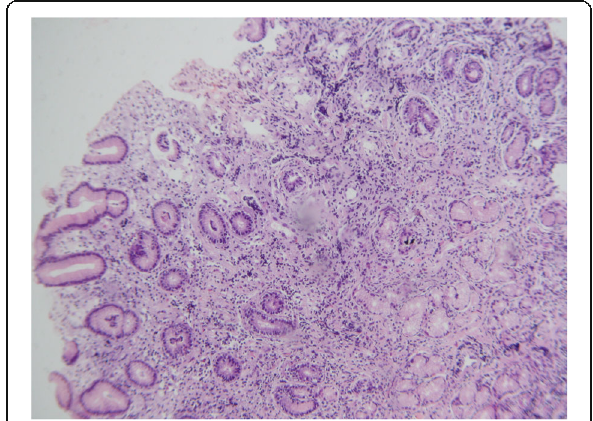
Fig. 2 Photomicrograph of a hyperplastic polyp of the gastric mucosa showing foveolar hyperplasia, without cytoarchitectural atypia (HE 200x)